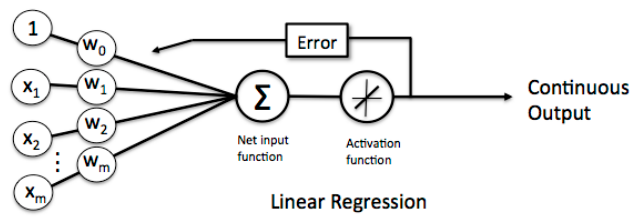
Figure 9. Machine learning-linear regression.